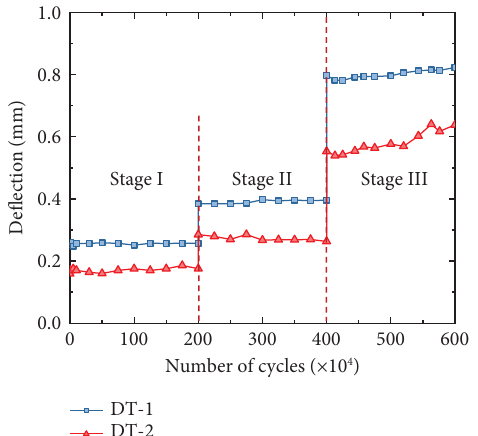
Figure 20: Variation laws of displacements during fatigue test.